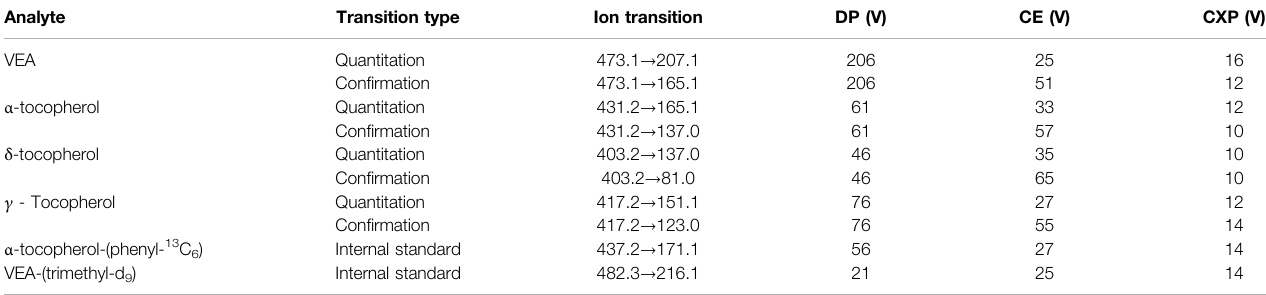
TABLE 1 | MRM transitions and parameters for VEA and tocopherols at a dwell time of 250 ms for all analytes. Analyte Transition